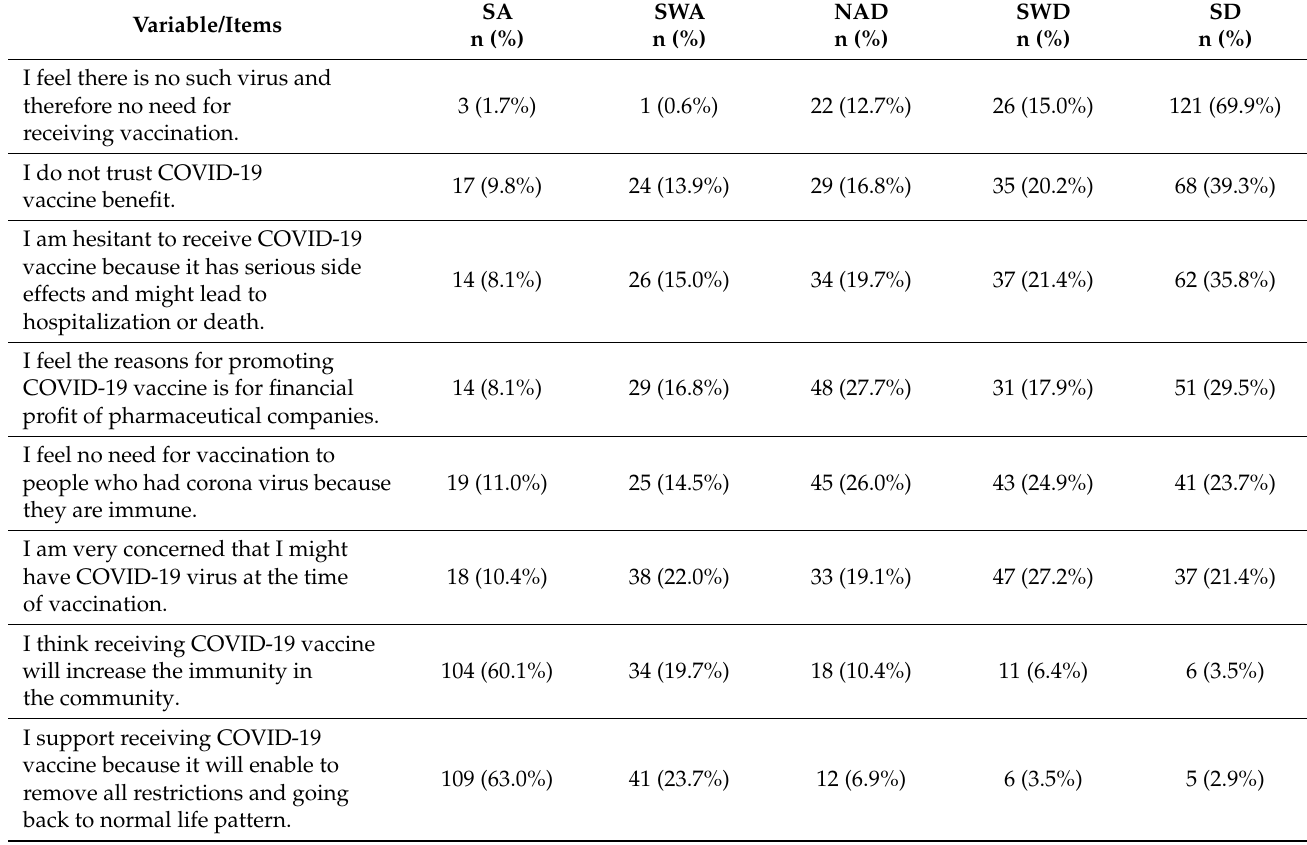
Table 6. Summary Statistics of the Attitude toward COVID-19 vaccination (n =